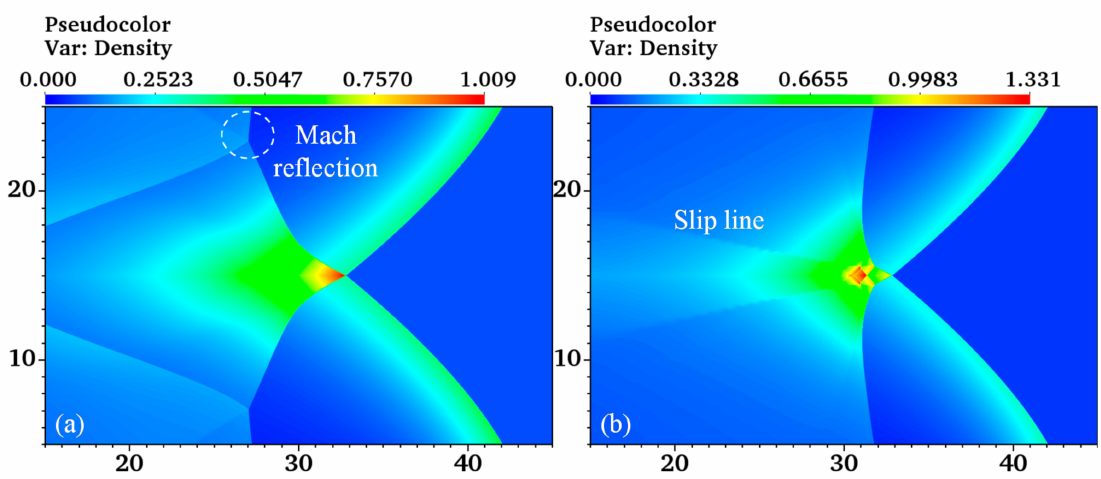
Figure 12. Shock wave interaction process in a jet diameter of 2.5 mm: ( a ) t = 200 µ s; ( b ) t = 235 µ s. As shown in Figure 13, after the initiation is completed, the detonation waves under different cases are overdriven forward at a stable speed. As shown in Table 6, when the jet diameter increased, the relative propagation velocity ∆ ν , absolute propagation velocity V , and overdrive degree f of the detonation wave also increased. This is because as the jet diameter increased, the jet penetration expanded and the height of the shear layer formed by the hot jets rose, which further compressed the gas mixture after the detonation wave, thereby accelerating the propagation of the detonation wave.